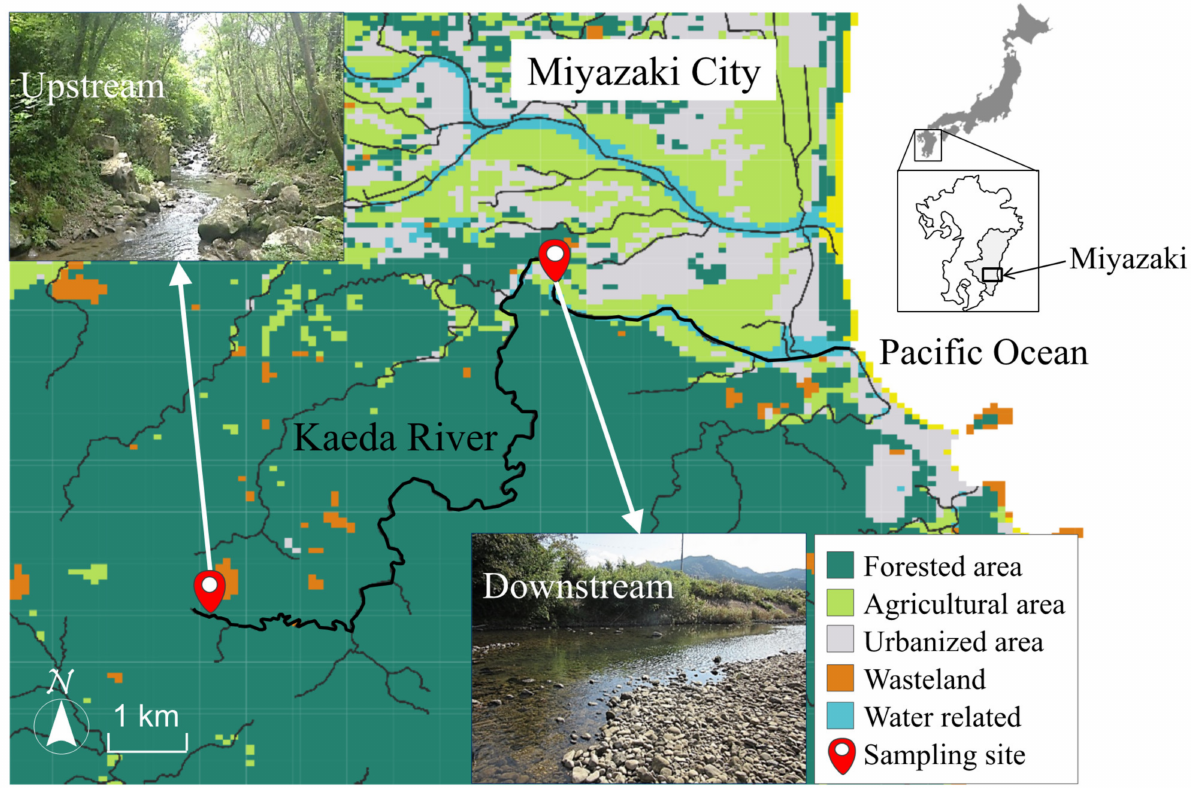
Figure 1. Sampling sites of pristine upstream and human-impacted downstream at the Kaeda River in southern Japan, with distribution of major land use